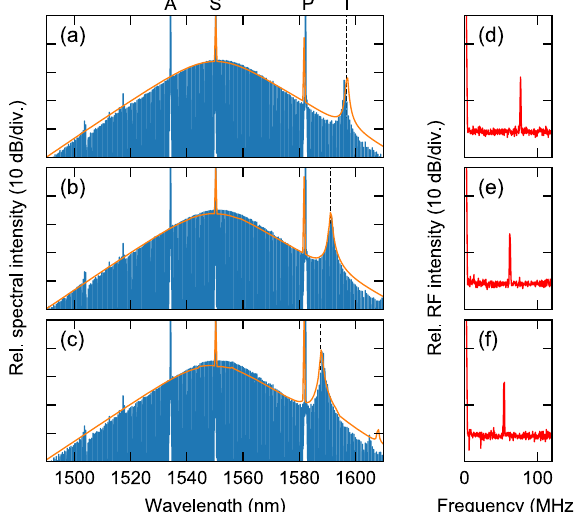
Fig. 4 Experimental spectra with positions of the soliton and probe waves interchanged. a – c The soliton is here generated at 1550 nm whilst the probe sits at 1582 nm. d – f Radio-frequency (RF) spectra corresponding to ( a – c ). The results shown are for different negative values of the probe detuning. Orange curves show results from numerical simulations. Labels A, I, P, and S on the top respectively indicate the auxiliary laser used for thermal compensation, the idler, the probe, and the